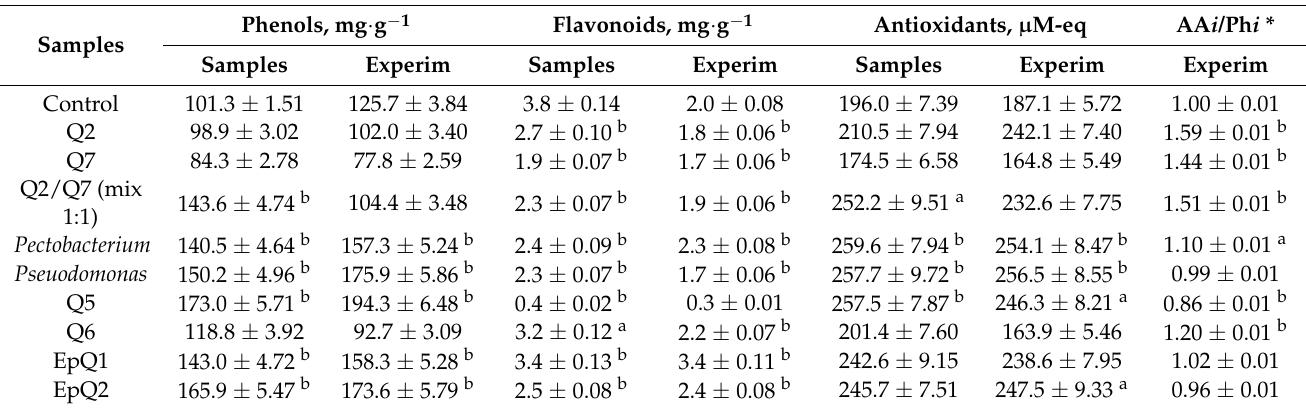
Table 3. The content of phenolic compounds in the leaves of common oak plants after inoculation with endophytic bacteria (x ± SE, n =